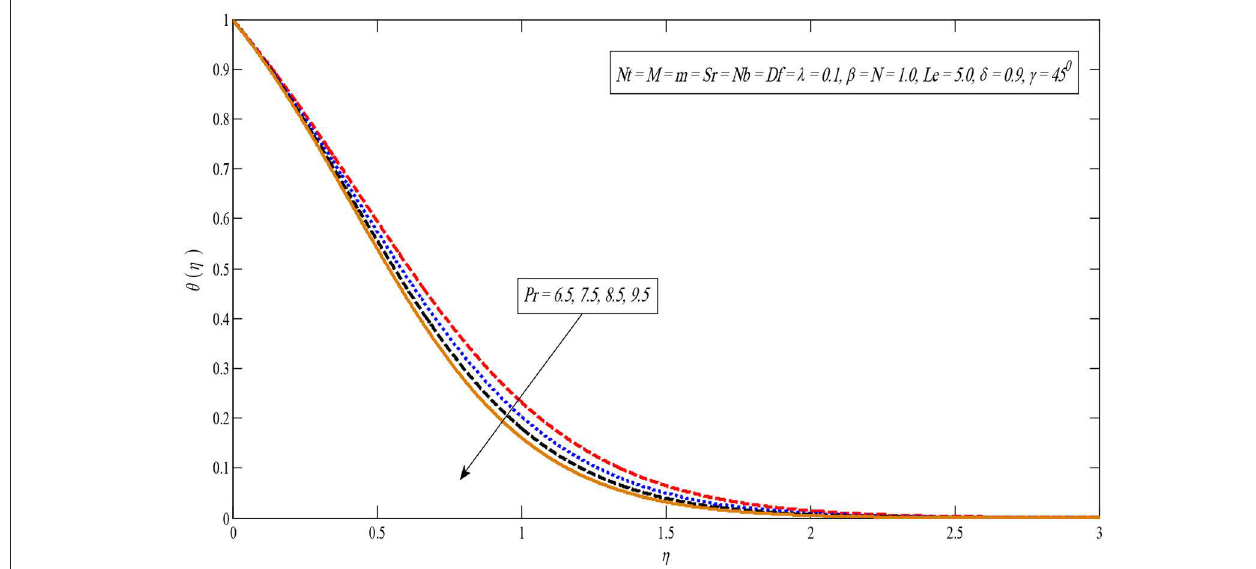
FIGURE 12 | Temperature profile for several values of Pr .